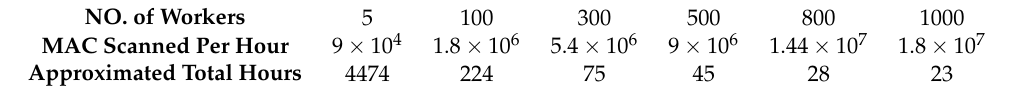
Table 6. Theoretical efficiency of MAC address scanning with different number of parallel computing